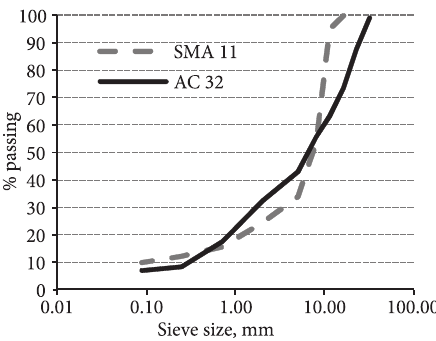
fig. 3. Asphalt mixtures aggregate gradation table 1. Asphalt mixtures design properties Bituminous